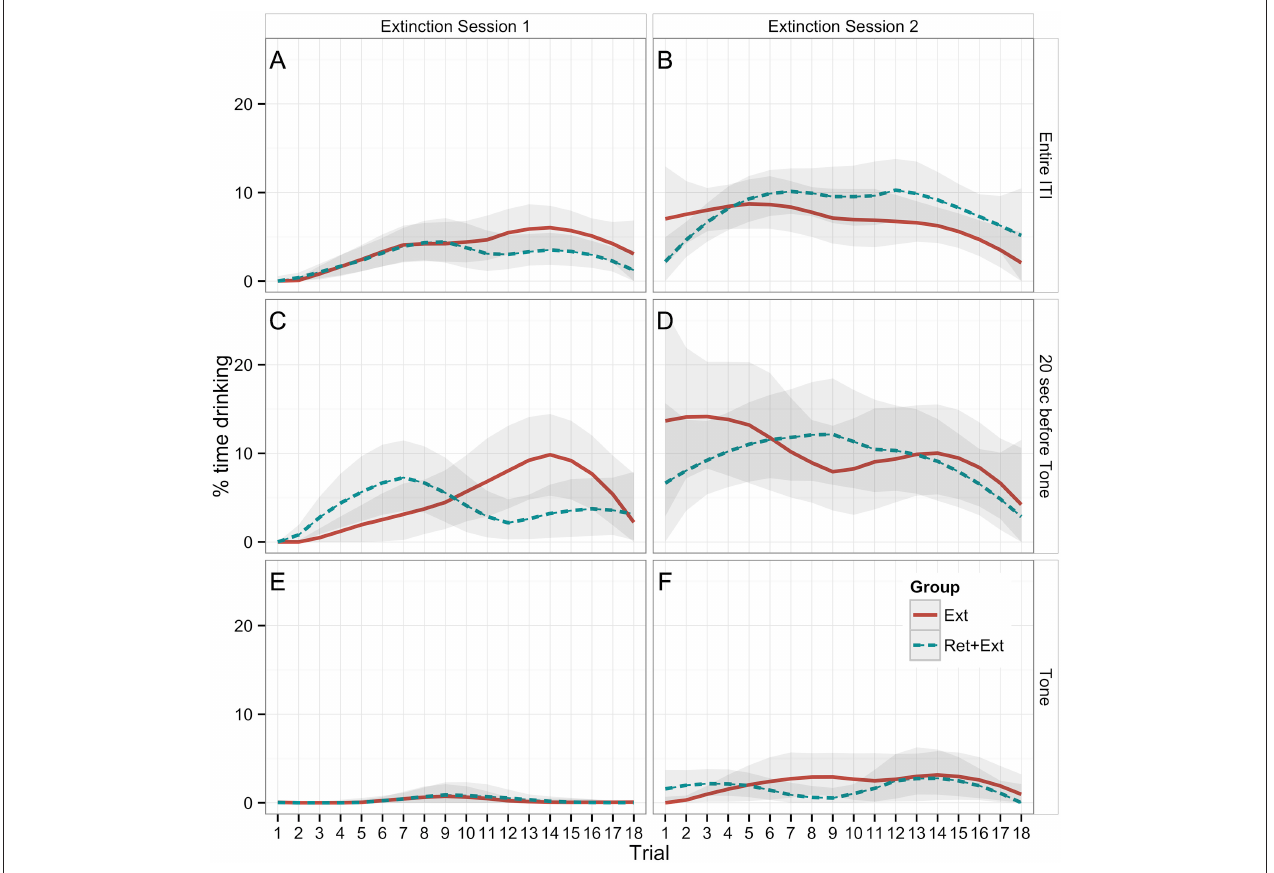
FIGURE 3 | Percent time that rats spent drinking during the first extinction session (A,C,E) and the second extinction session (B,D,F) across all 18 trials. The (A,B) (Entire ITI) shows drinking as averaged across the entire ITI for each trial (the entire time between tones), and the (C,D) (20sec before Tone) shows drinking during the 20s immediately preceding each tone. Both can be used to compare with drinking during the 20s Tone CS (E,F) . The Ret + Ext group experienced a 1-h break between the first and second trials of both extinction sessions (Extinction Sessions 1 and 2). Lines represent LOESS-predicted extinction curves with bootstrapped 95% confidence bands. Extinction to context was significantly greater than extinction to tone. There were no significant group